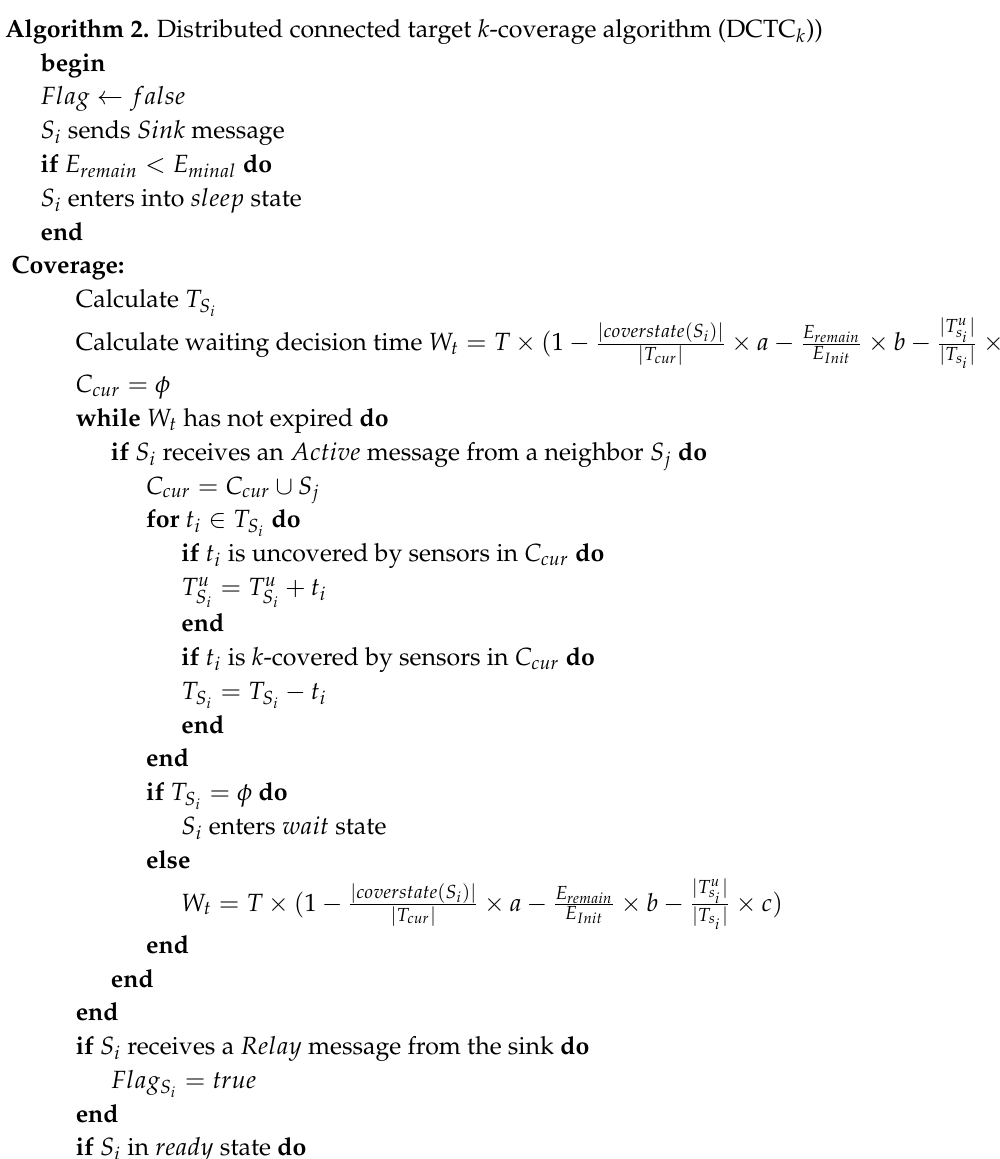
Algorithm 2. Distributed connected target k -coverage algorithm (DCTC k